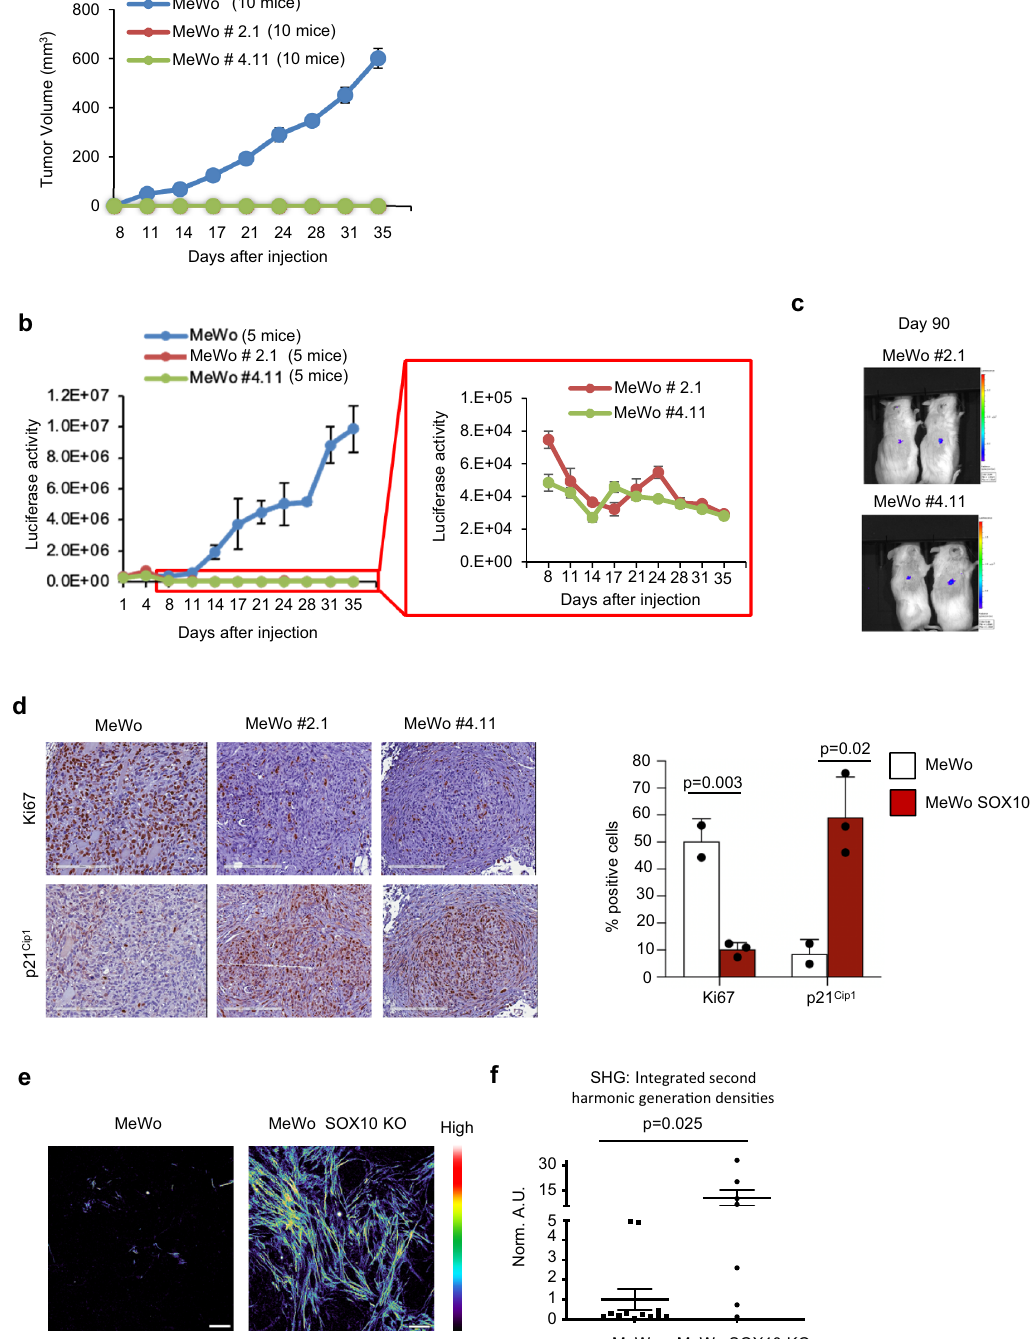
(Supplementary Fig. 5A). In IncuCyte growth assays, birinapant reduced cell growth in SOX10 knockout cells compared to parental cells in a statistically signi fi cant manner, either at all doses analyzed for MeWo #2.1 or at higher doses (50 and 100 nM) for MeWo #4.11 (Fig. 6b and Supplementary Fig.